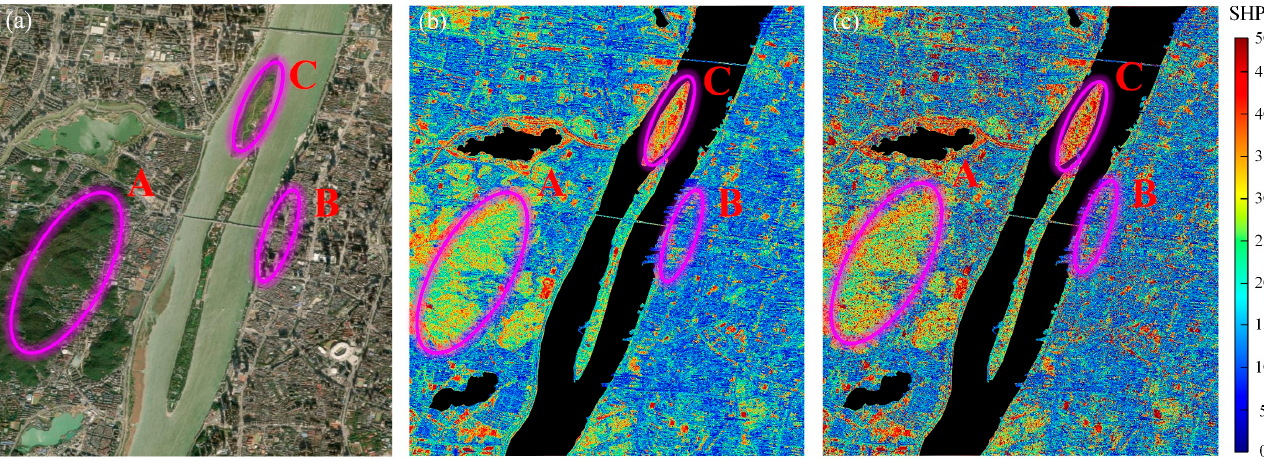
Figure 4. Results of SHP identification. ( a ) Optical image. ( b ) Results of a homogeneous pixel number with a [7, 7] window. ( c ) Results of AWHPSPO (A represents the Yuelu Mountain area; B represents the high-rise group area of Wanda Plaza; C represents the northern area of Orange Island).